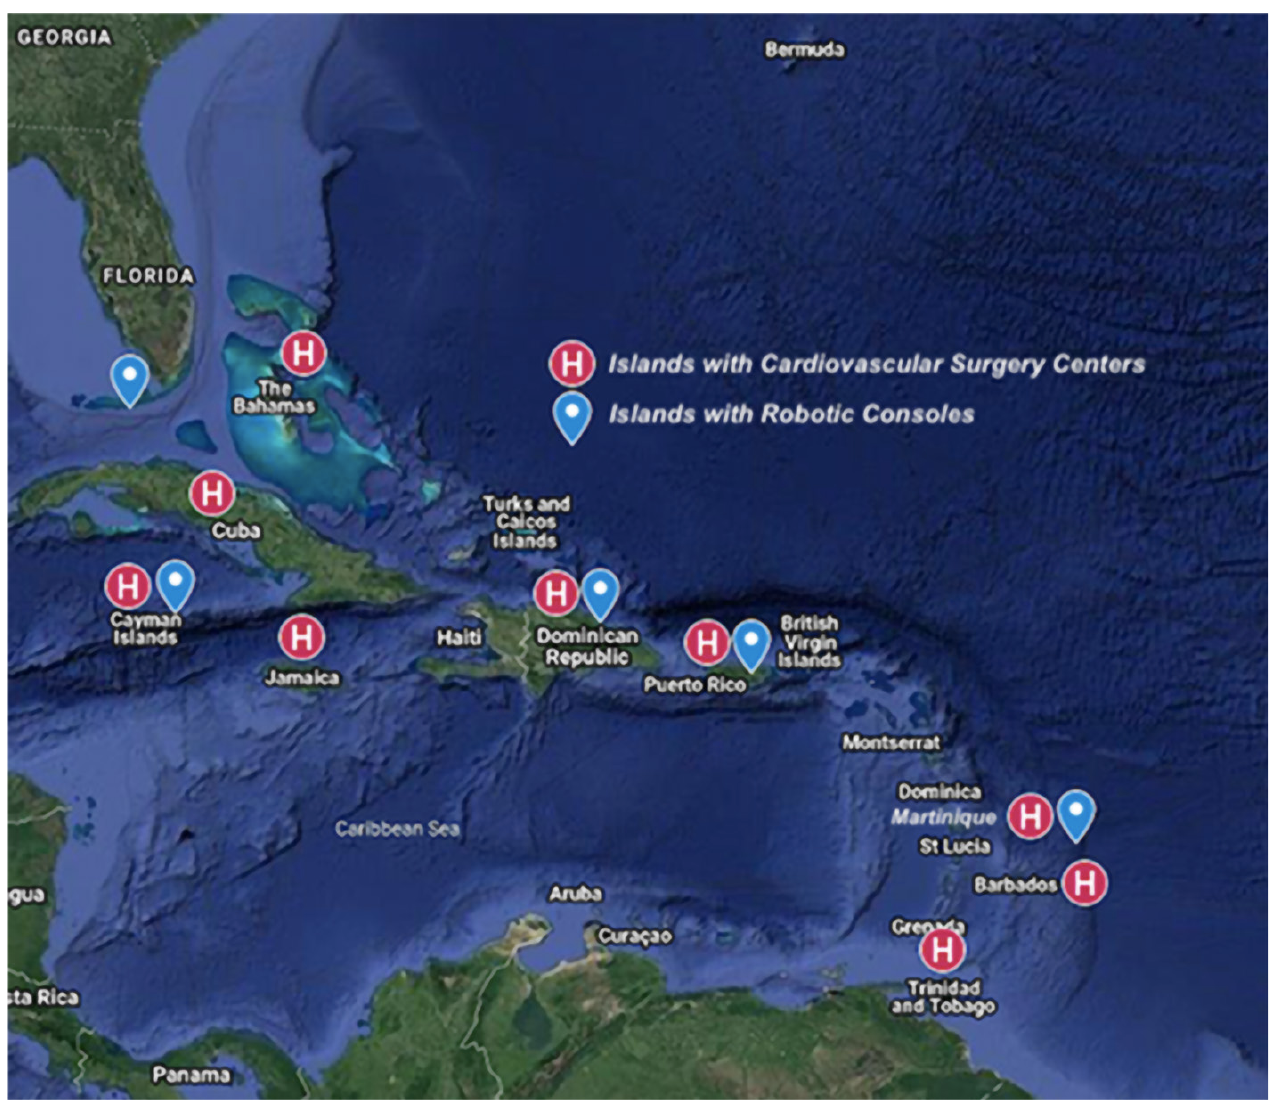
Fig. 1 - Distribution of Caribbean islands with cardiovascular surgery centers and robotic